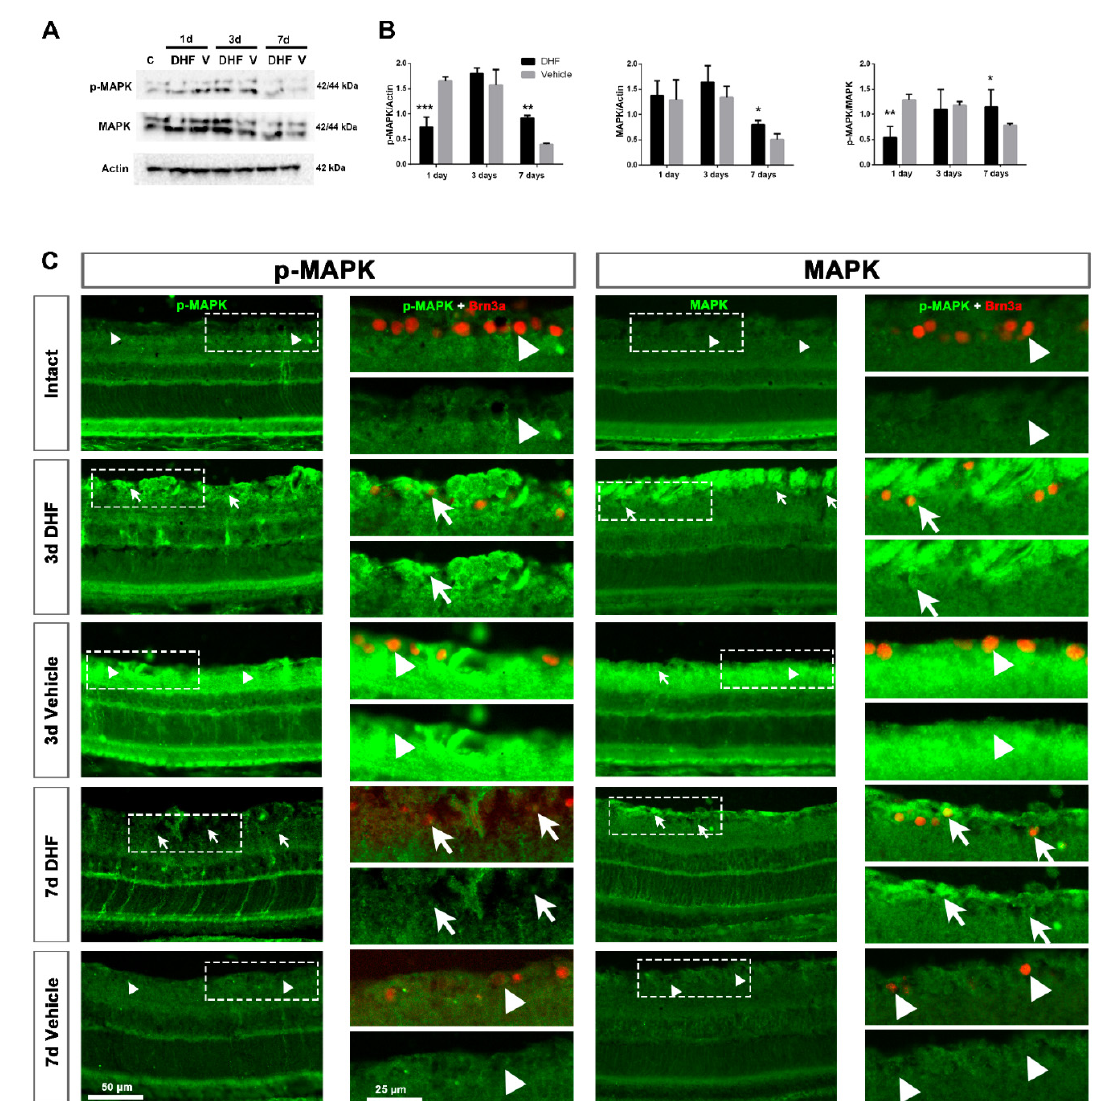
Figure 1. MAPK signaling pathway. Representative images of Western blot ( A ) from MAPK protein levels in retinal samples (pool of four samples/time-point). Western blot was performed with retinal extracts from intact (c, control) and left injured retinas treated daily with DHF or vehicle (V) analyzed at 1, 3 or 7d after IONT. ( B ): Bar graphs of the quantitative analysis of phosphorylated ( p -) MAPK and the total MAPK protein compared to actin protein levels, and normalized p-MAPK/MAPK. In all graphs, results are presented as mean ± SD relative to intact retinas (considered 1.0). Kruskal–Wallis test, * p < 0.05, ** p < 0.01, *** p < 0.001). ( C ): Representative cross-sectioned retinas (20×) of p-MAPK (left) and total MAPK (right) signal in intact and axotomized retinas treated with DHF or vehicle at 3 and 7 days after IONT. In the right column of each one, a magnification of double immunostaining with Brn3a (upper part) and p-MAPK or MAPK alone (lower part) is shown, pointing the co-expression (arrows) and no co-expression (arrowheads) between them. RNFL = retinal nerve fiber layer, GCL = ganglion cell layer, IPL = inner plexiform layer, INL = inner nuclear layer, OPL = outer plexiform layer, ONL = outer nuclear layer, PRL = photoreceptor layer, RPE = retinal pigment epithelium, d = days post-lesion. Scale bar is shown at the bottom left.